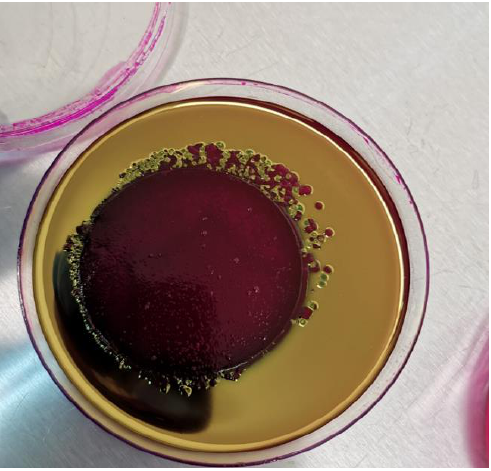
Figure 1. Colonies of Escherichia coli grown on m-Endo Agar LES, producing a dark-red metallic sheen.